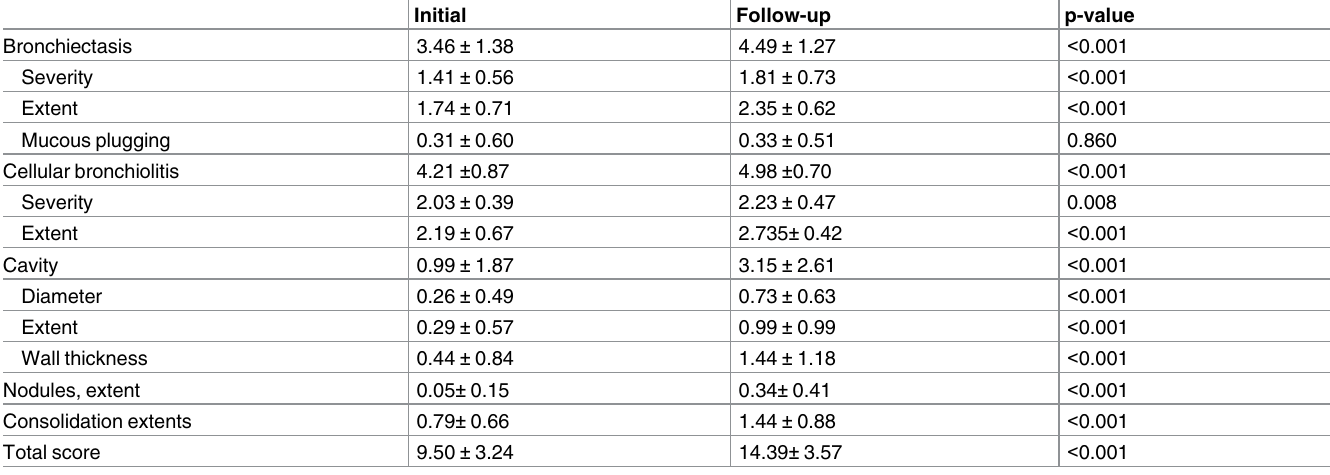
Table 4. Comparison of CT scores of 10 parenchymal abnormalities between initial and follow-up CT in 40 patients with MAC lung